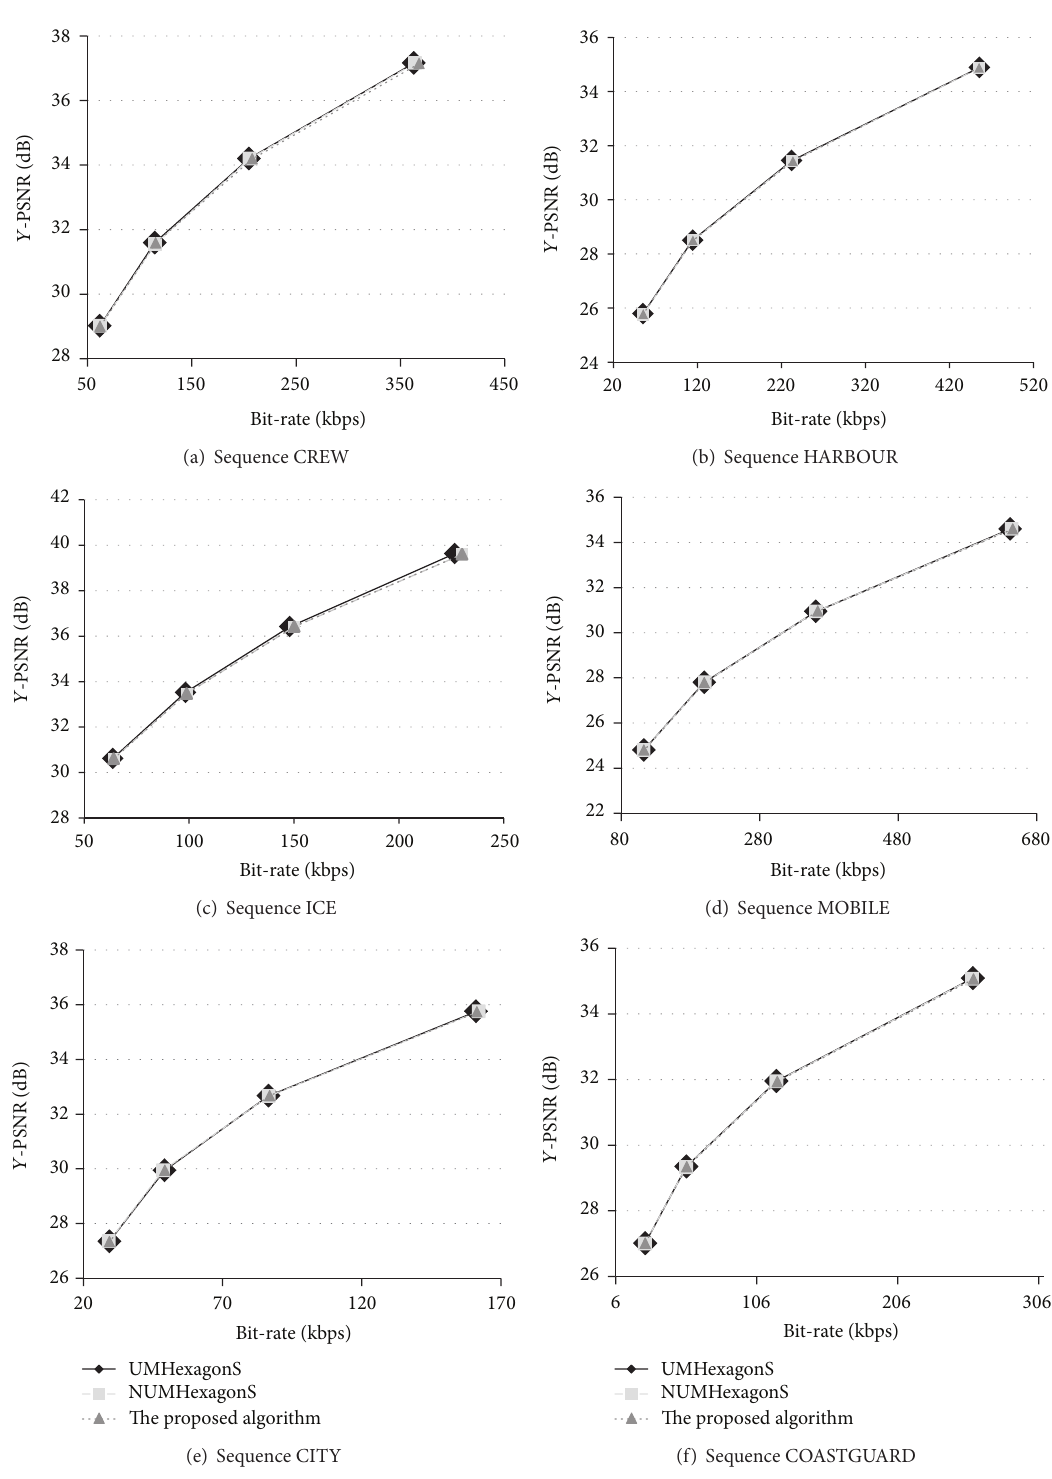
Figure 13: Comparison of rate-distortion performance between UMHexagonS, NUMHexagonS, and the proposed